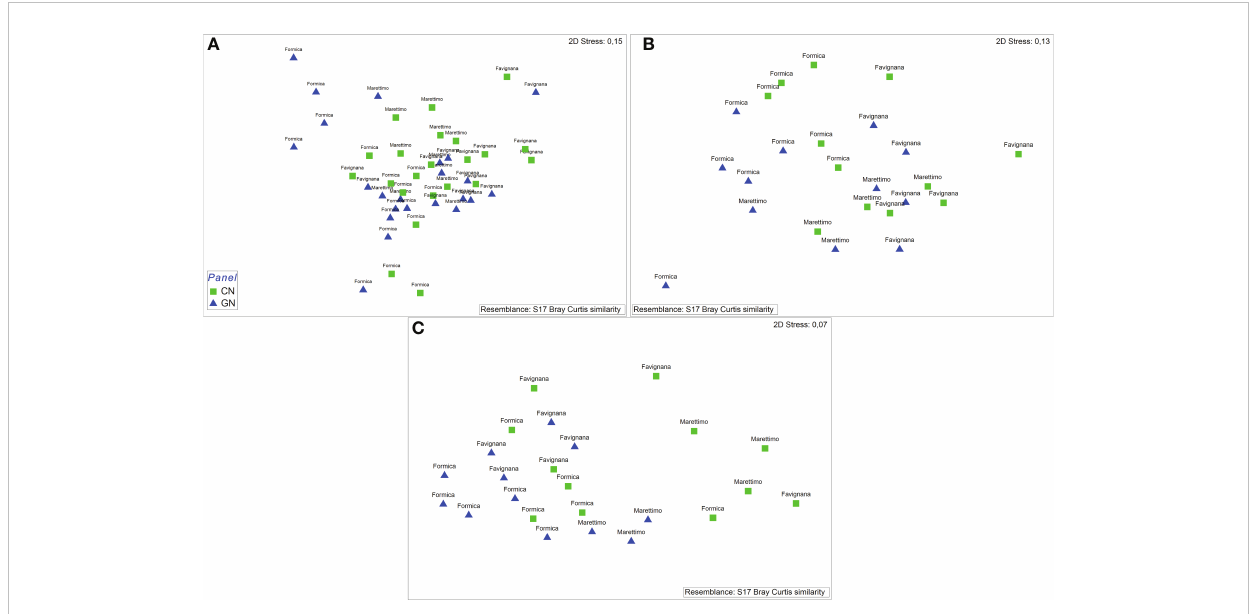
FIGURE 4 (A – C) Non-metric multidimensional scaling plot of total catch abundance ( A ), commercial catch ( B ), and non-commercial invertebrate discard (C) caught in 48 experimental fi shing trials with standard (CN) and modi fi ed (GN) panels by